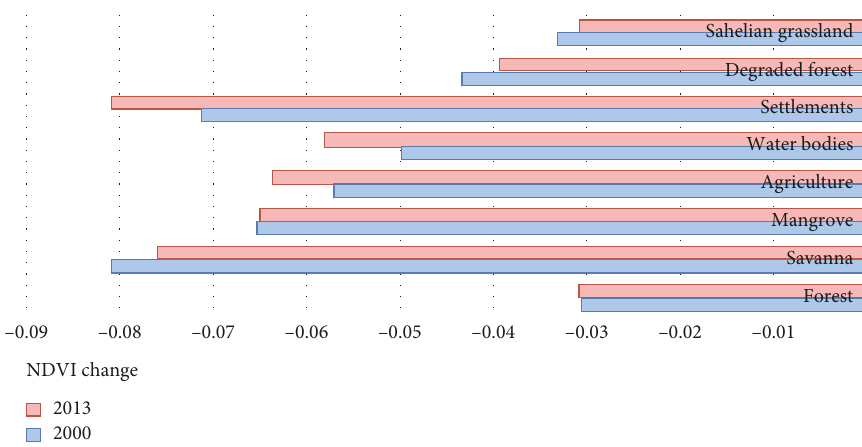
Figure 10: Changes in NDVI between 1975 and 2010 (adapted and modified from [34,